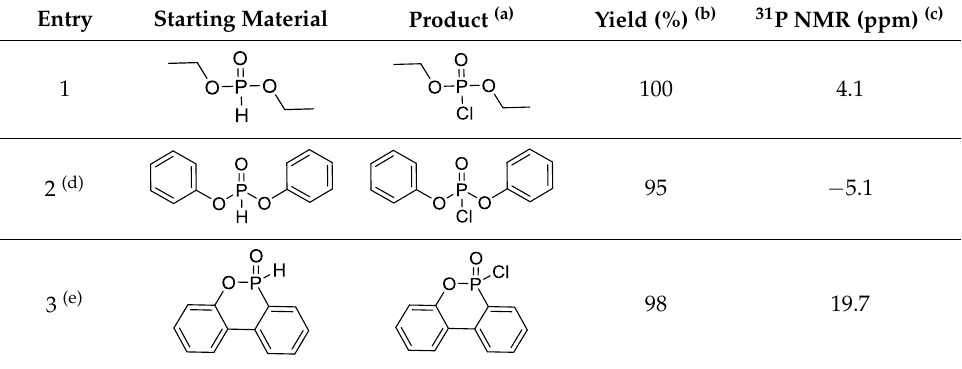
Table 1. Chlorination reaction of different organophosphorus compounds using N -chlorosuccinimide (NCS). Entry